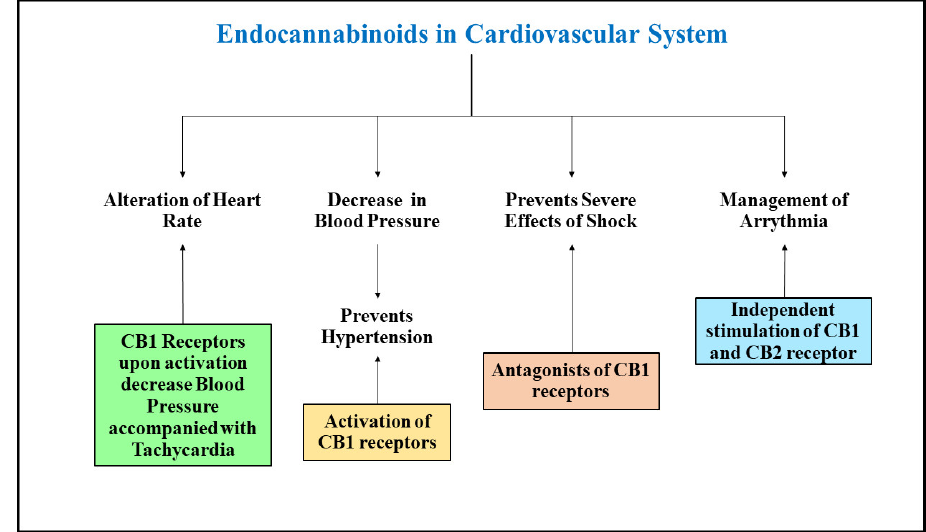
Figure 3. The figure describes the protective role of Endocannabinoids in management of cardiovascular disorders.